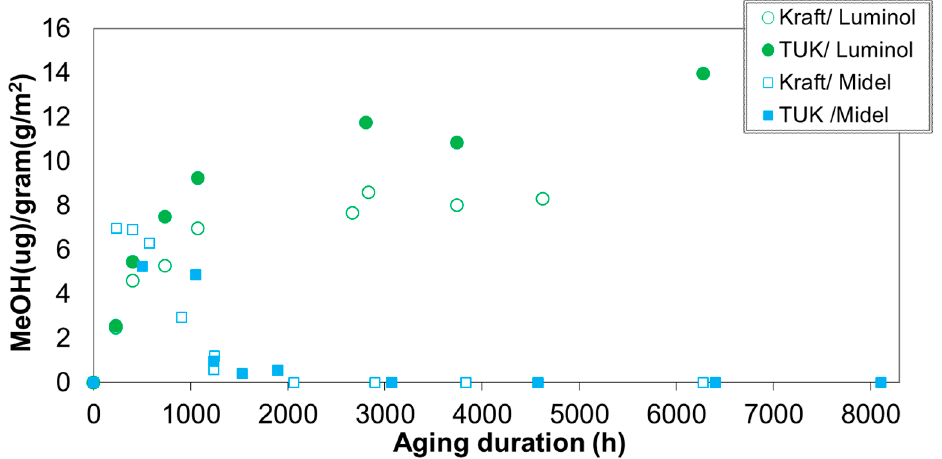
Figure 9. Concentration of methanol with ageing time, from [23].